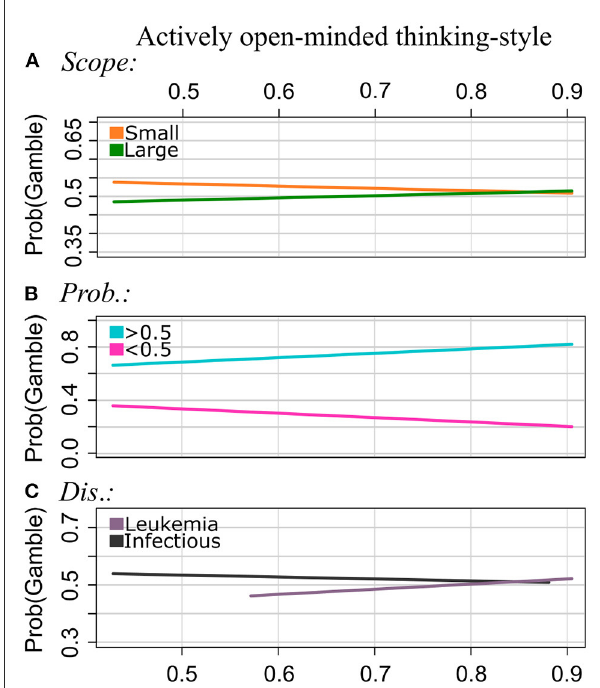
FIGURE2 Experiment 1: Regression lines of the proportion of choosing the gamble option as a function of AOT, separately for the levels of Scope [pattern (A) ], Probabilities (B) , and Disease (C) . Note that we applied a smaller range of values on the y-axis for the plots of the patterns (A–C) to illustrate the interaction effect more clearly.